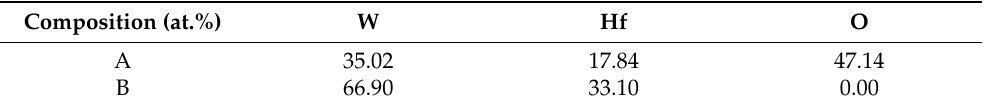
Figure 6. Ablation analysis of the sample cross-section: ( a ) W-1.5 Y, ( b ) W-1.5 Y-10 Hf, and ( c ) W-1.5 Y-20 Hf. ( d ) EDS analysis of the element distribution in ( c ). Table 4. Element analysis of the points in Figure 6c.